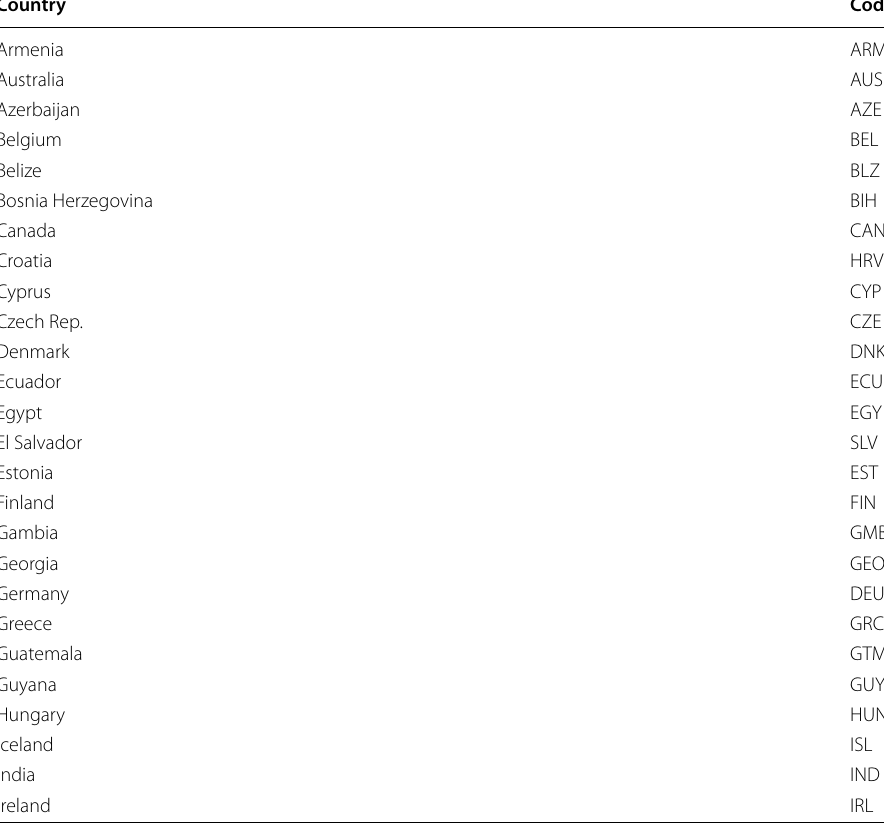
Table 11 List of countries of the WTN